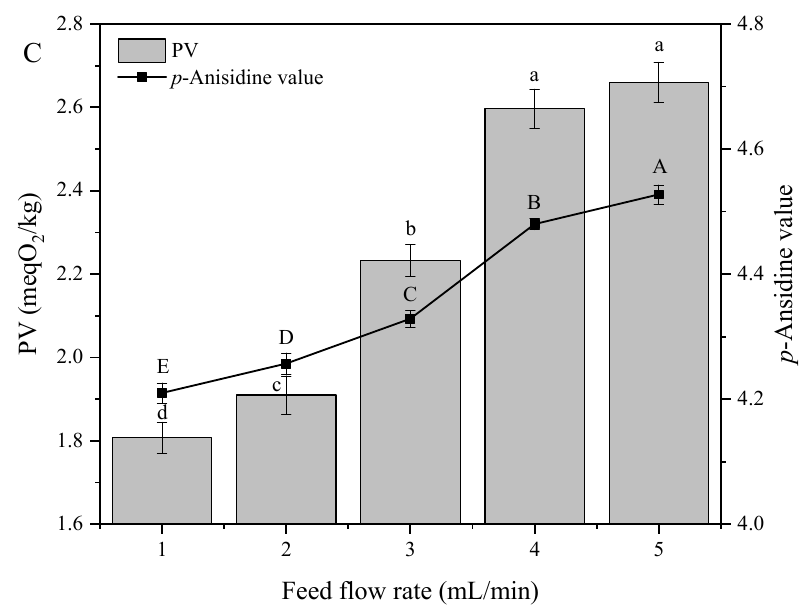
Figure 2. Effect of ( A ) evaporation temperature, ( B ) scraper speed, and ( C ) feed flow rate on the peroxide (PV) and p ‐anisidine values of soybean oil. Note: The lowercase letters of a‐d indicate that there are significant differences in peroxide value under different treatment conditions; the capital letters of A–E indicate that there were significant differences in p ‐anisidine value under different treatment conditions.